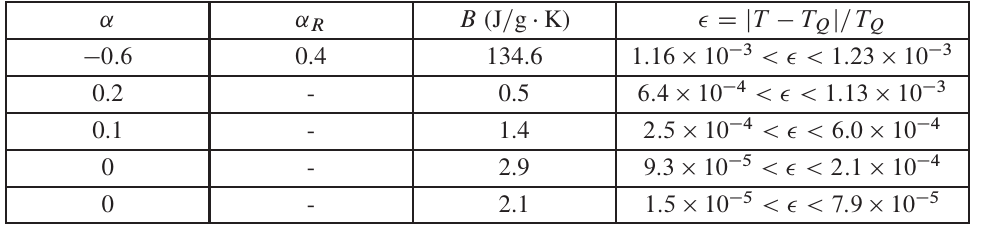
Table 2. Values of the critical exponent ˛ for the specific heat C p and the amplitude B within the temperature interval (cid:4) for the ˛ - ˇ phase transition ( T Q D 577:1 ı C) in quartz according to Eq. (1) where A D 1:2 J = g (cid:3) K. The experimental C p data was analyzed below T Q along heating curve. The renormalized ˛ R values (Eq. 3) are also given here.